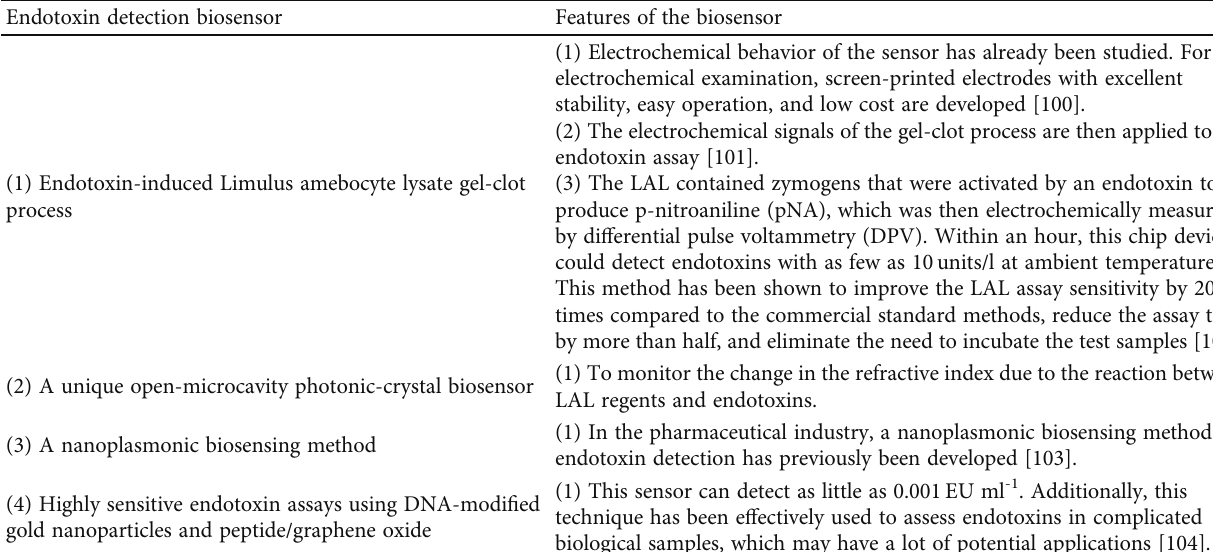
Table 6: Endotoxin detection biosensor and their